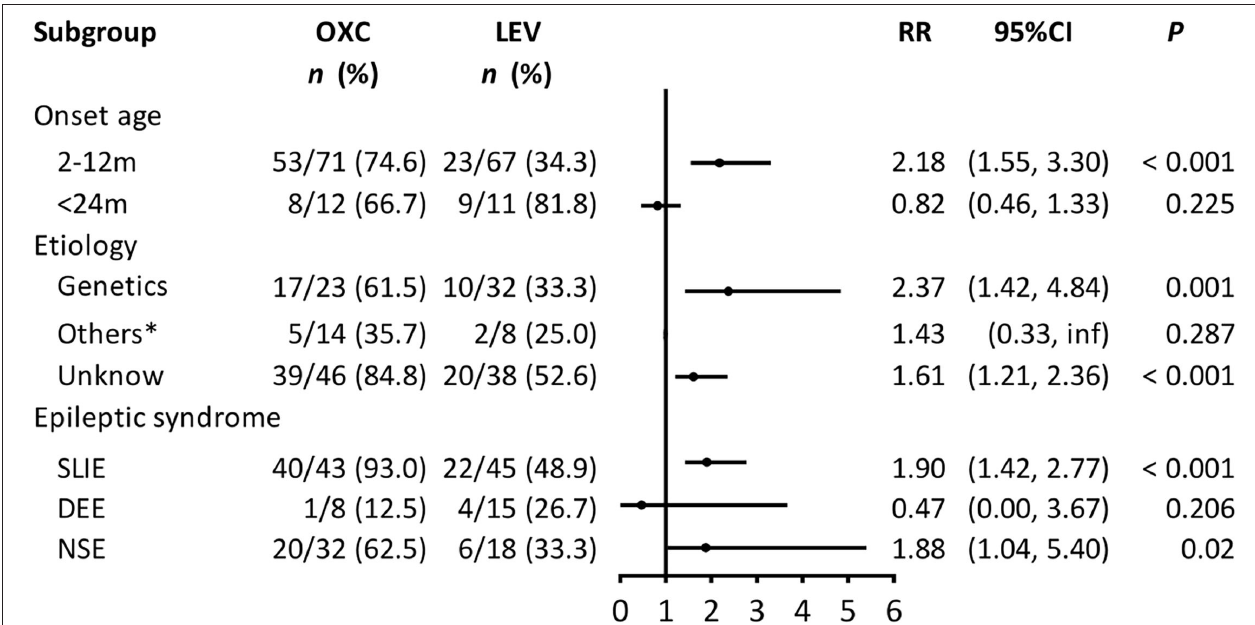
FIGURE 2 | Subgroup analysis of the association between treatment and seizure outcome ( n = 161). OXC, oxcarbazepine; LEV, levetiracetam; CI, confidence interval; RR, risk ratio; SLIE, self-limited infantile epilepsy; DEE, developmental and epileptic encephalopathies; NSE, non-syndromic epilepsy. Others*: includes structural, infectious, metabolic causes; we could not calculate the 95% CI because of the small sample